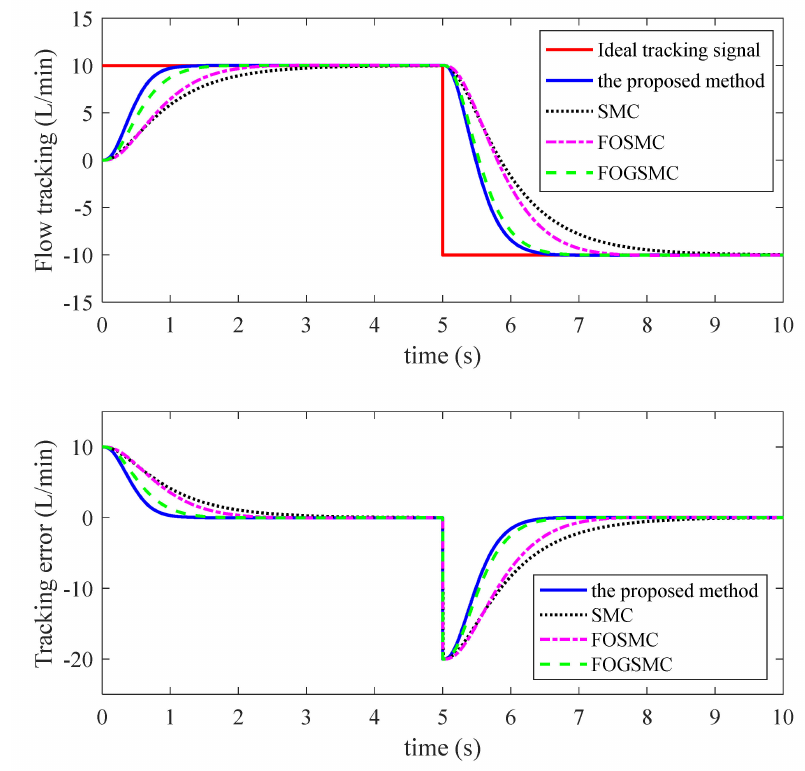
Figure 9. Time response of glue flow tracking and tracking error.